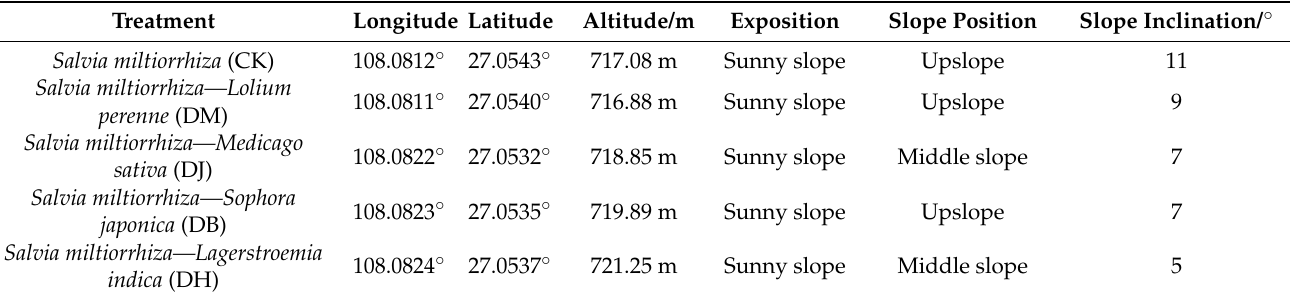
Table 1. Sampling point location and